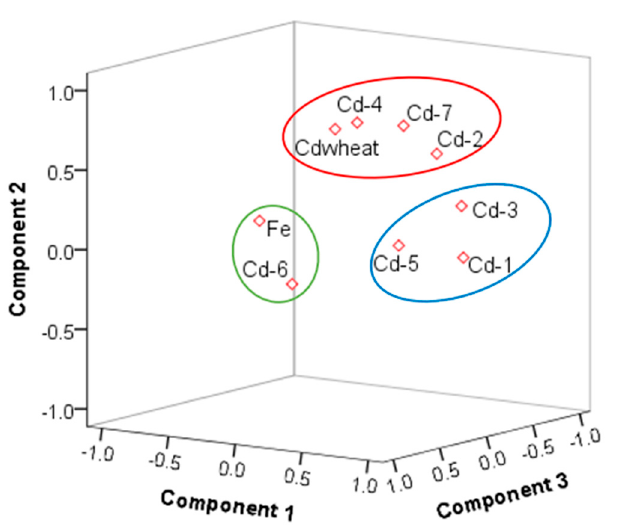
Figure 4. The three components plotted in rotated space (the circles represent the different source components).